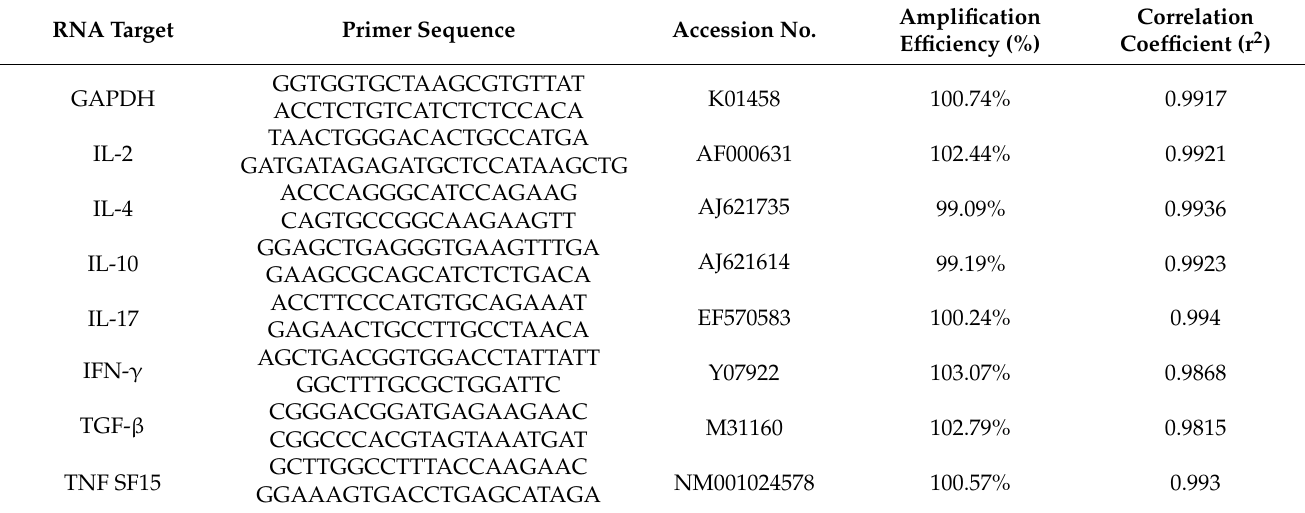
Table 2. Specific primer sequences of quantitative real-time PCR.